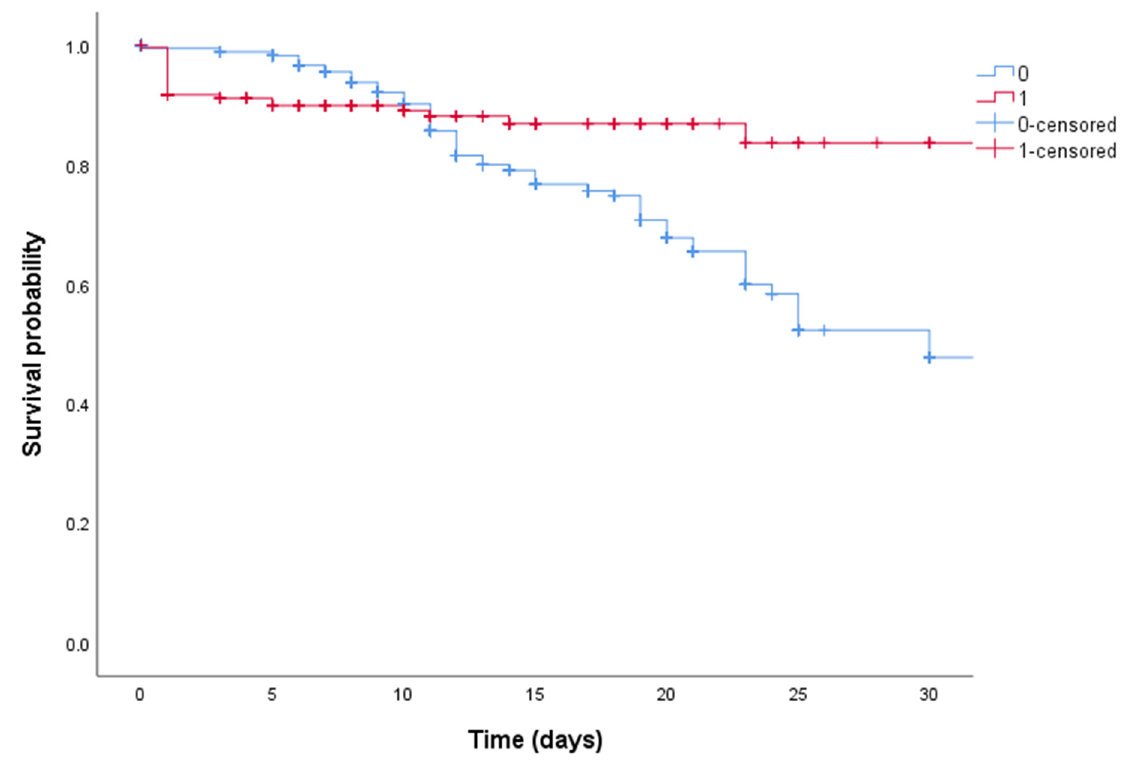
Figure 1. Kaplan–Meier curves of all COVID-19 patients treated with high-dose steroid therapy (red line) or standard-dose steroid therapy (blue line).